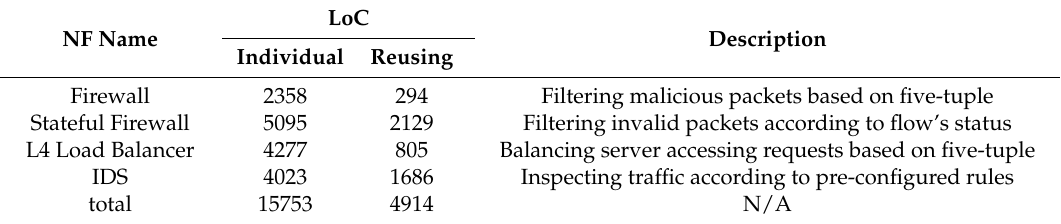
Table 1. The LoC of four NFs developed in two methods: individual and